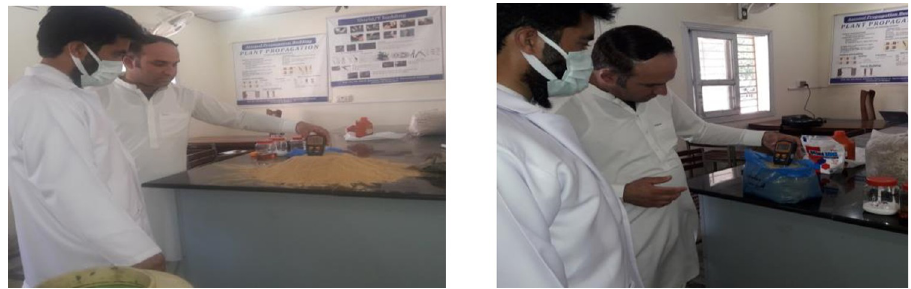
Fig 3. Calculation of moisture content of biomass pellets biofuel prototypes.